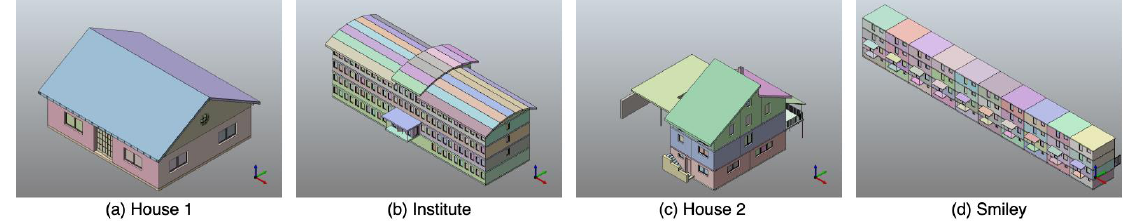
Figure 13. Models processed and visualized using OCCT.